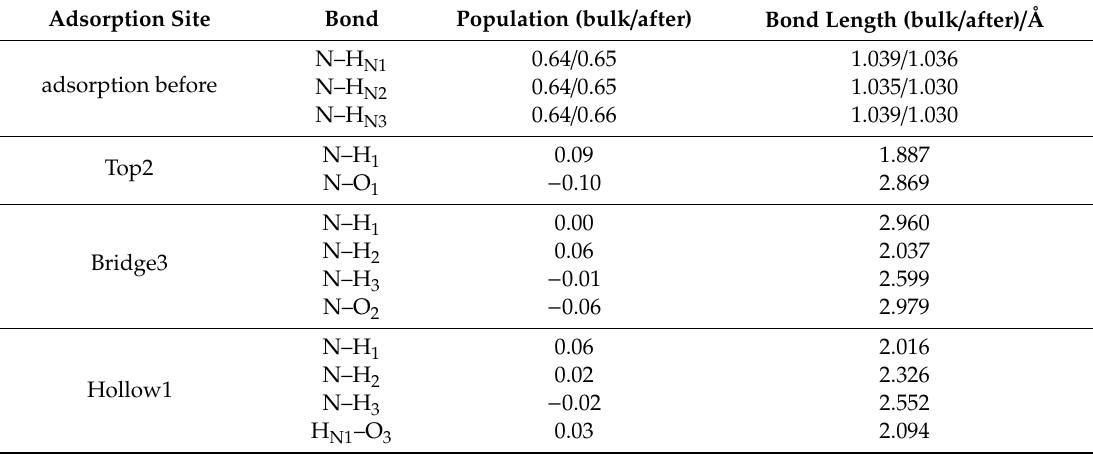
Table 4. Mulliken bond population of atoms before and after NH 3 adsorption on kaolinite (001) surface (Top2, Bridge3 and